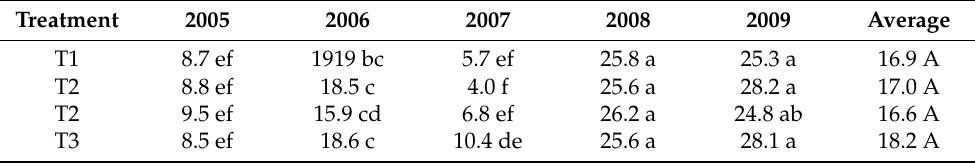
Table 2. Influence of the treatment on olive yield per tree between 2005 and 2009 (kg tree − 1 ). Treatment